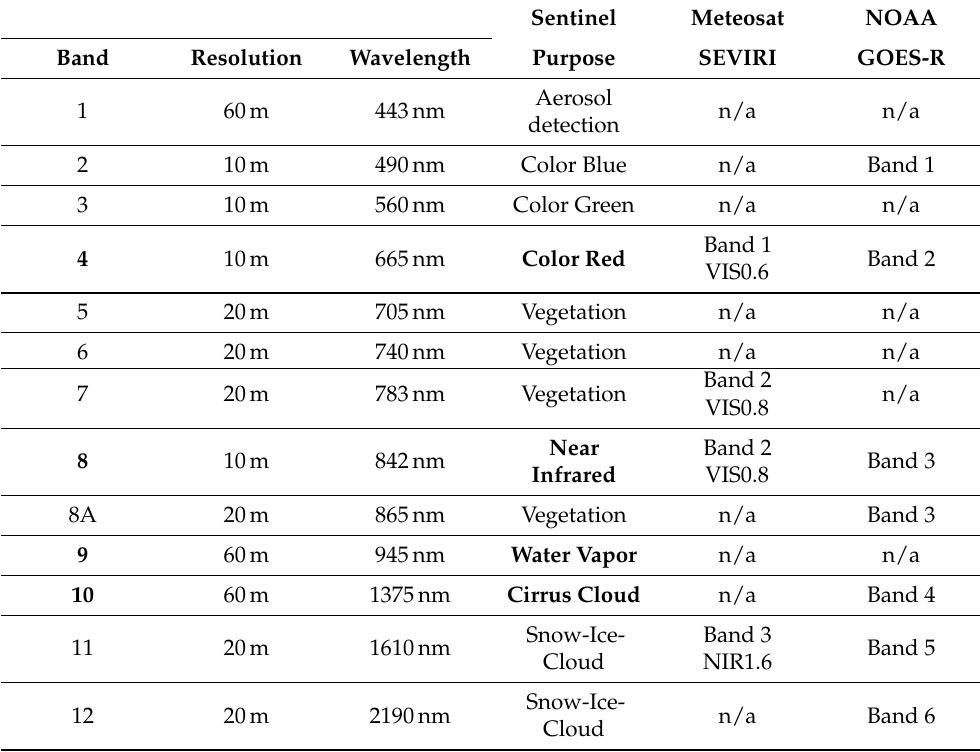
Table 2. Sentinel 2 vs. Meteosat SEVIRI vs. NOAA GOES (closest correspondence